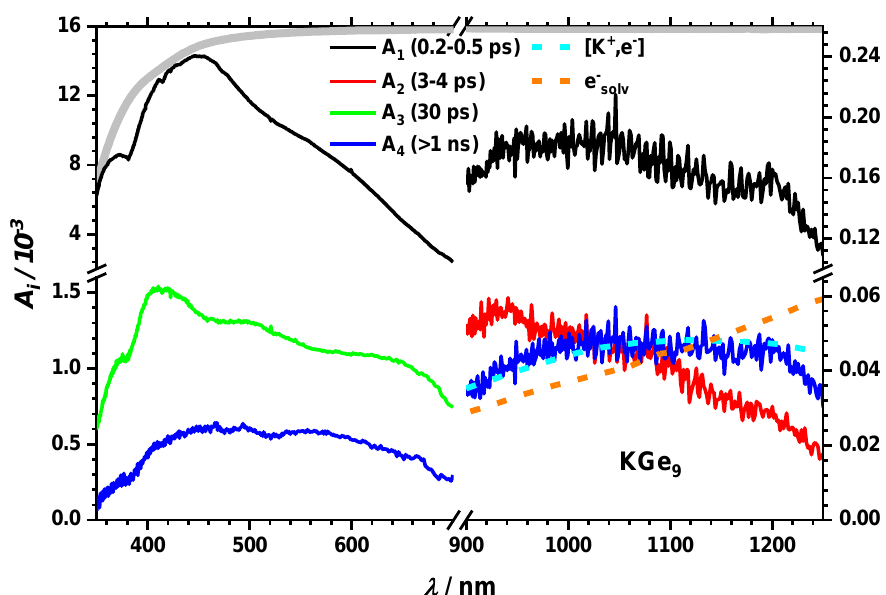
Figure 6. DAS after 267/258 nm excitation for KGe 9 in THF. Dashed blue and orange lines show a [K + ,e − ] contact pair [40] and a section of the absorption of the solvated electron in THF [37]. The corresponding transient spectra and all spectra for LiGe 9 can be found in SI Figures S3–5.